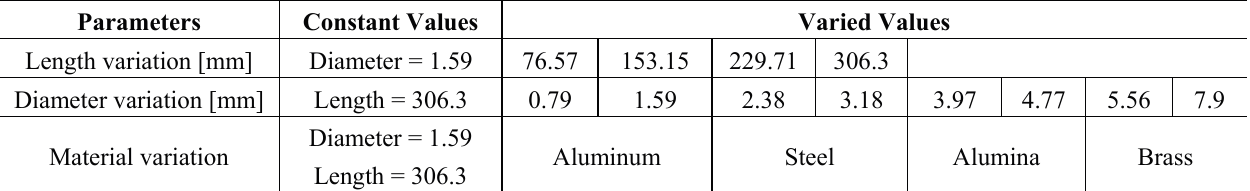
Table 2. Parameters for cases